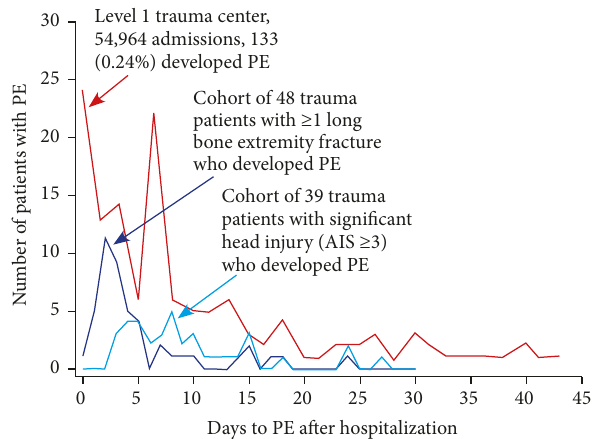
Figure 2: Time course to pulmonary embolism (PE) in patients at level1traumacenters.AIS=AbbreviatedInjuryScale.Adaptedfrom Brakenridge et al. [19] and Coleman et al.